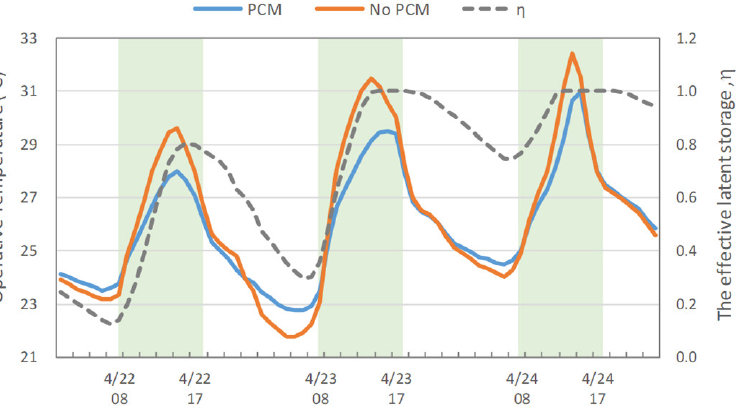
Figure 8. Comparison of simulating operative temperatures of classrooms with and without PCM roofs during the ventilation season.